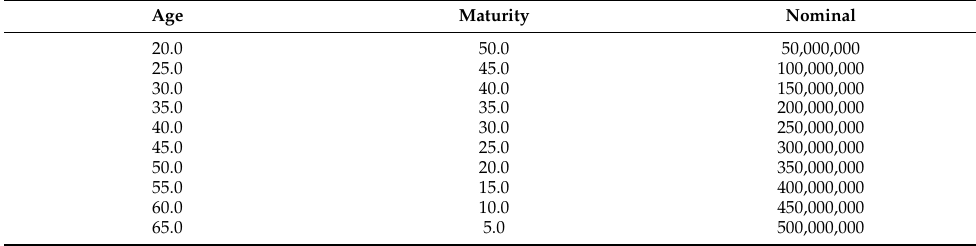
Table 2. Obtained solution in Example 2 with BH.